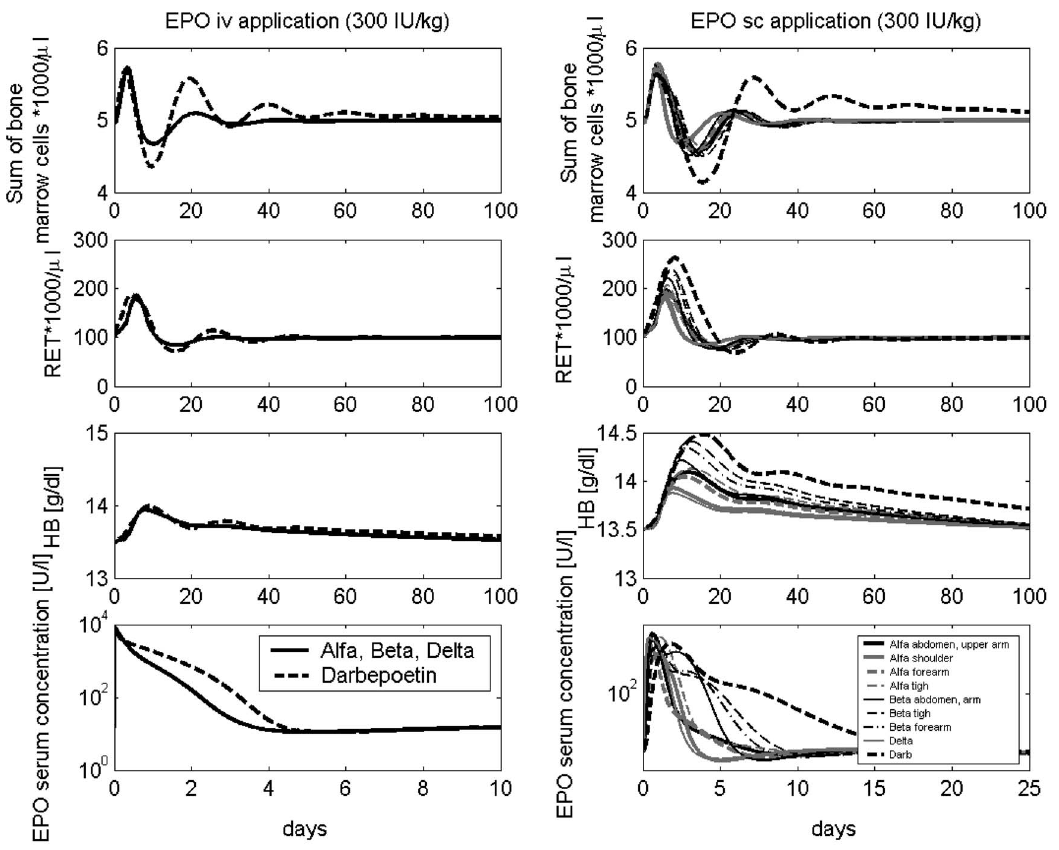
Figure 7. Comparison of injection modes. Comparison of erythrocytes, reticulocytes, HB values, and the sum of the bone marrow cell stages after intravenous (left) and different subcutaneous injection sites (right).